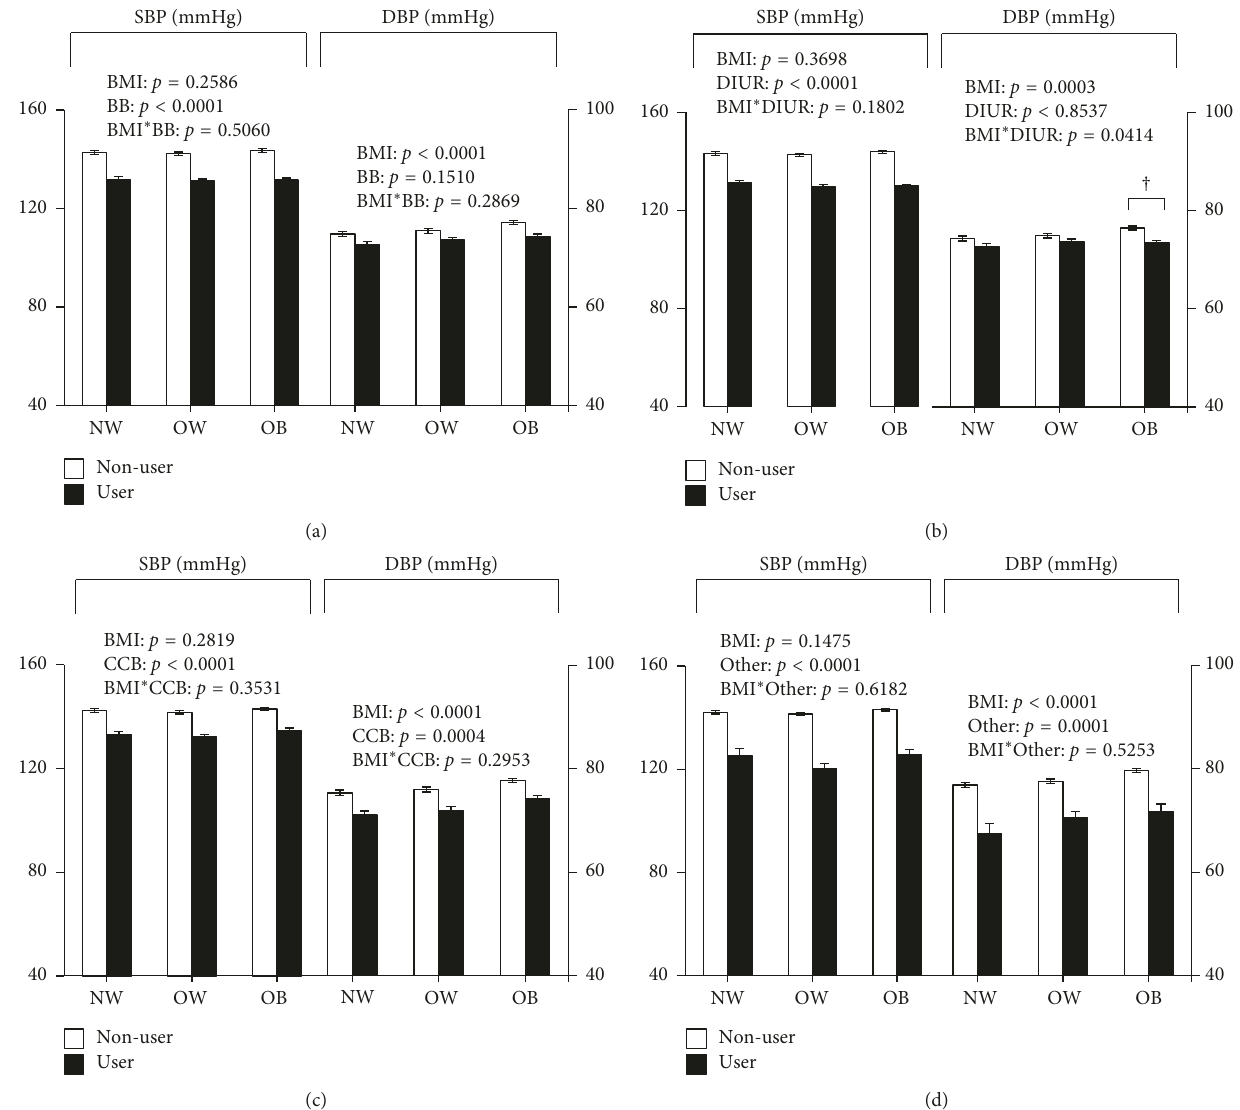
Figure 1: Mean systolic and diastolic blood pressures (mmHg) among hypertensive adults using (a) β -blockers, (b) diuretics, (c) CCBs, and (d) other antihypertensive drugs by BMI category. Sample includes individuals on combination antihypertensive therapy. Means are adjusted for age, gender, ethnicity, health insurance status, smoking status, physical activity, education, and number of antihypertensive medications taken. BMI � body mass index; BB � β -blocker; DIUR � diuretic; CCB � calcium channel blocker; NW � normal weight; OW � overweight; OB � obesity; SBP � systolic blood pressure; DBP � diastolic blood pressure. ∗ Difference between users and nonusers significantly different from normal weight ( P < 0 . 05); † difference between users and nonusers significantly different from overweight ( P < 0 .